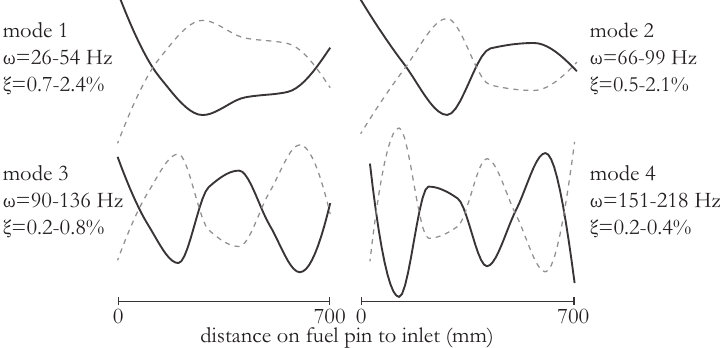
Figure 7. Experimentally estimated mode shapes and approximate eigen-frequency and damping ranges during external excitation of the fuel